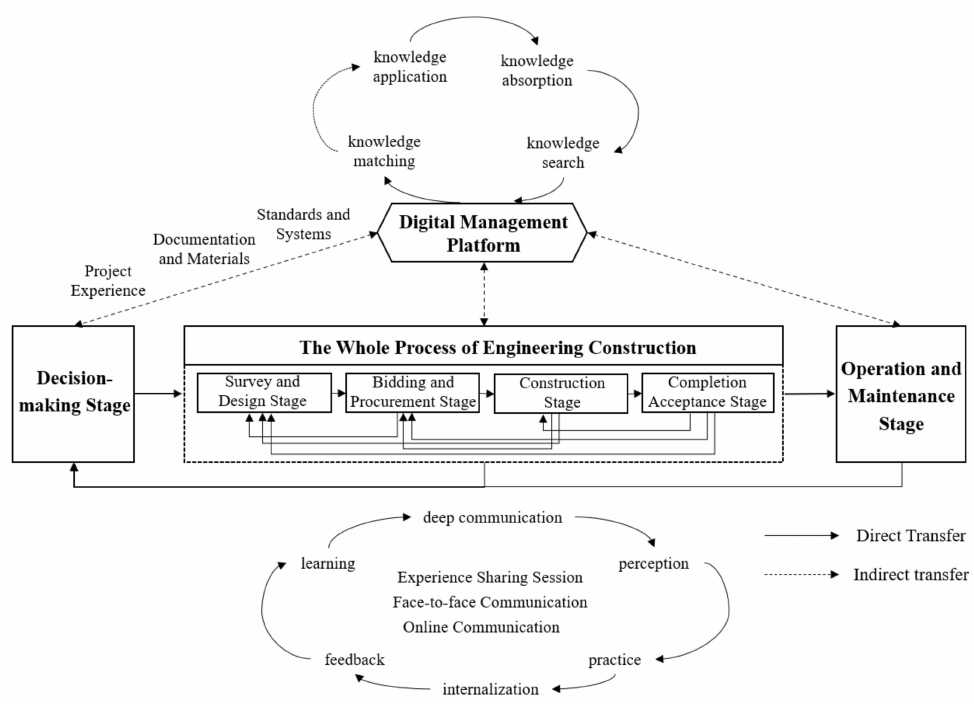
Figure 1. Knowledge transfer process of each business stage of the whole-process engineering consulting project with a digital management platform as the